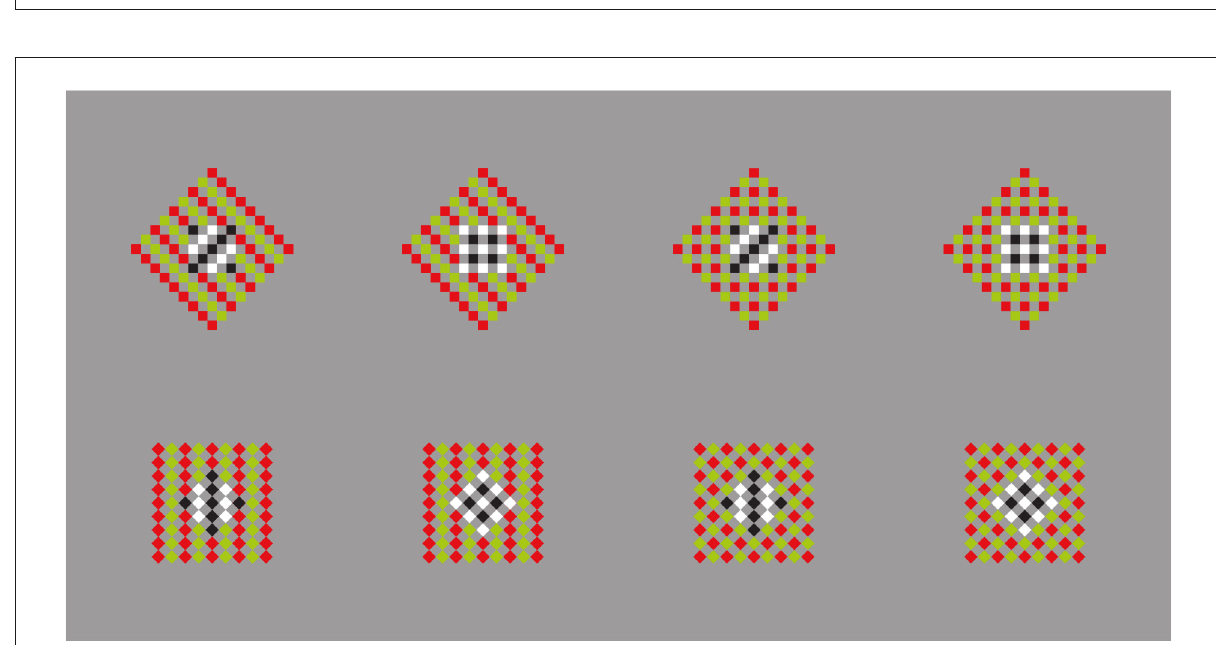
FIGURE10 Illusory squares and diamonds within surrounding diamonds (first two columns) and squares (the other two columns) and included black and white elements made of squares (first row) and diamonds (second row).